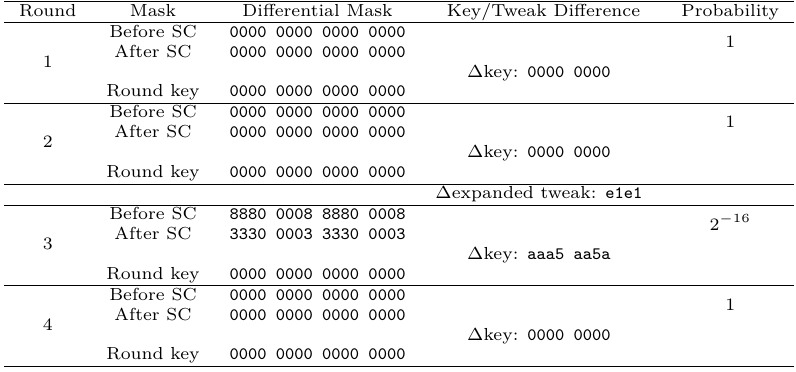
Figure 4: Six 4-round cores of TweGIFT-64 . T e denotes the 16-bit expanded tweak. Table 2: Differential Trail with p core = 2 − 16 in the Related-Key